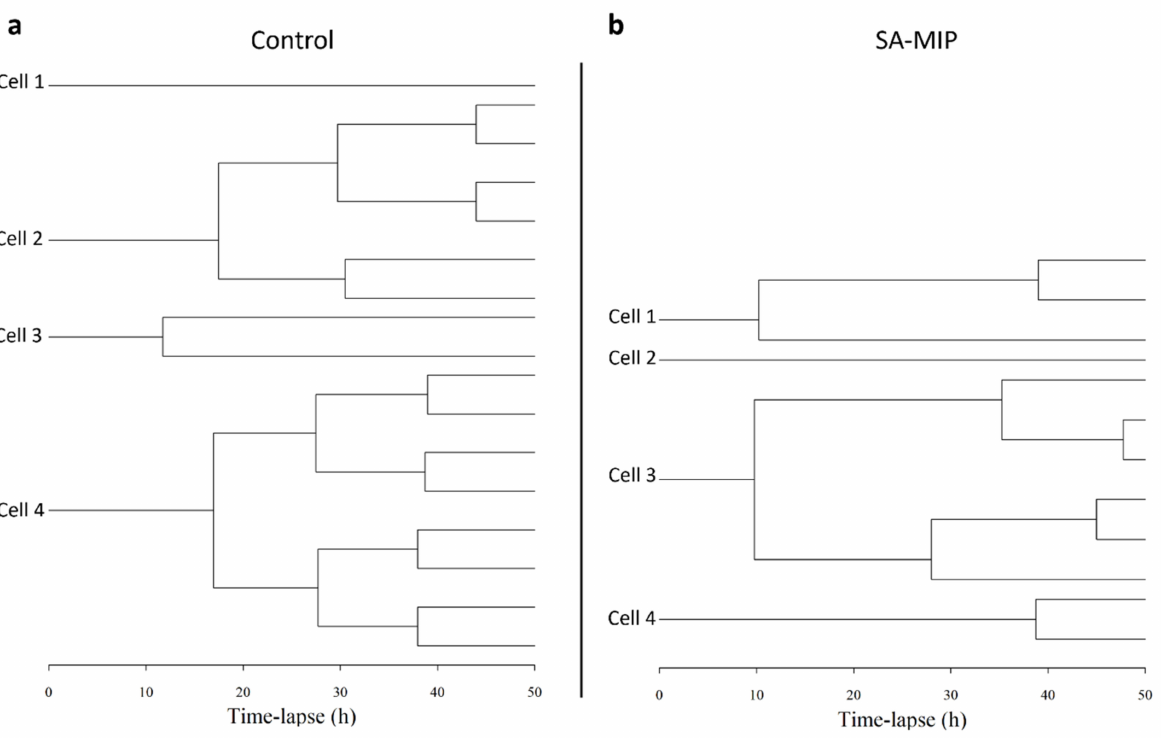
Figure 7. Schematic cell family trees for RAW-264.7 cells. RAW 264.7 cells were incubated with culture medium only ( a ) or with 40 µ g/mL SA-MIP ( b ) for 48 h. Holographic images were captured every 15 min at several positions, thus creating 48 h time-lapse movies. For every capture position, cells in the first image (0 h) were selected and tracked until division. In the schematic cell family trees, each forking of the line indicates a cell division. The resulting daughter cells of each cell division were identified, and tracking continued throughout the 48 h time-lapse. In total 109 control cell family trees and 91 SA-MIPs treated cell family trees were